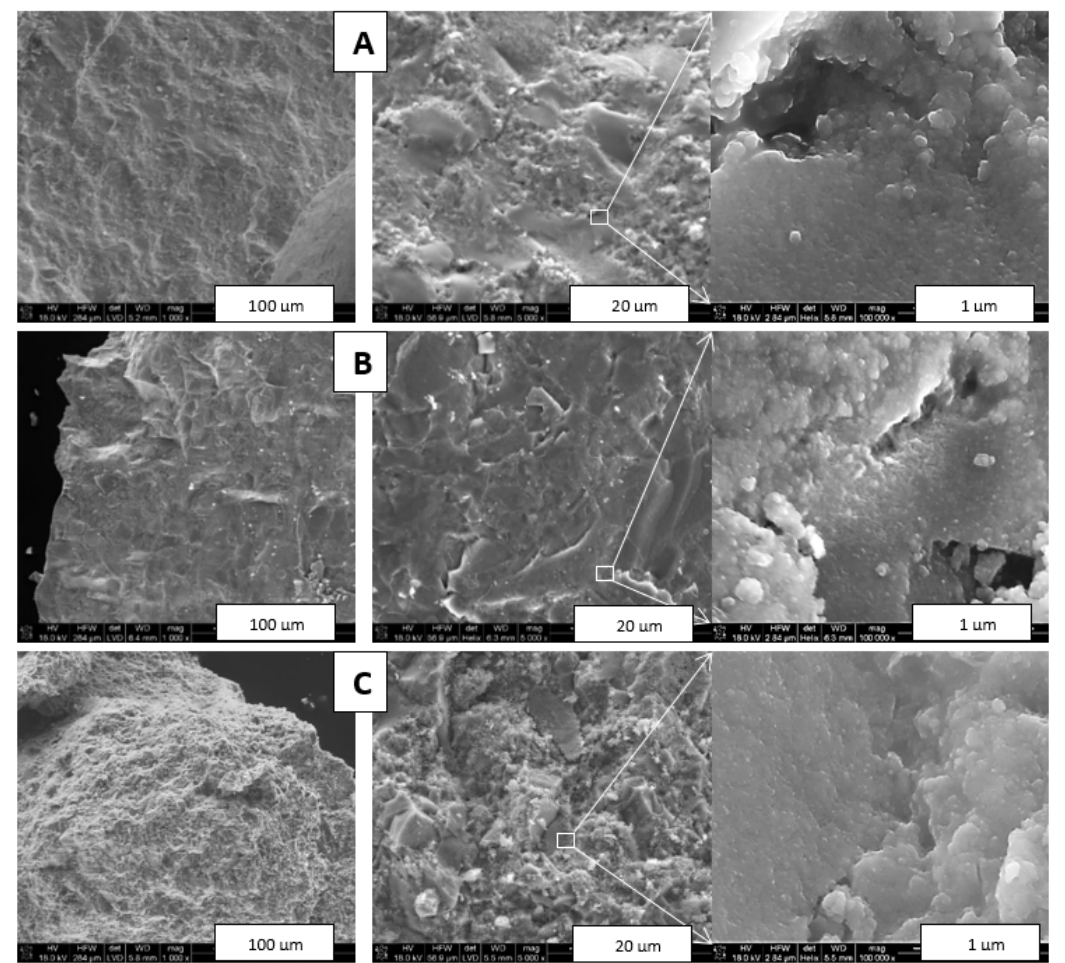
Figure 4. SEM images of intentionally fractured nanoceramics sintered from Composite_950: ( A )—Composite_950_sint_650, ( B )—Composite_950_sint_1000, ( C )—Composite_950_sint_1200. Areas in white-edged rectangles are magnified by a factor of 20 and are shown in adjoining images.